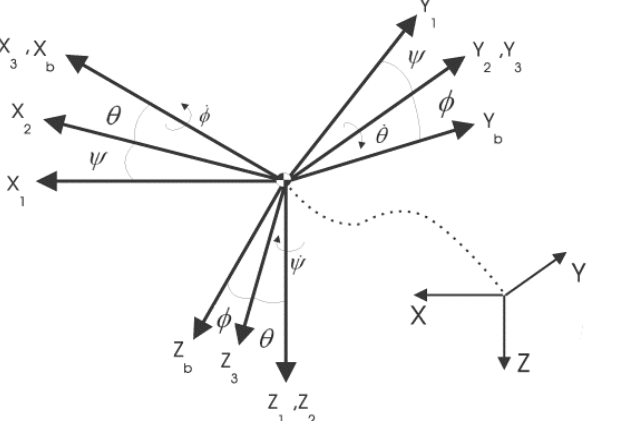
Fig. 1. The body-fixed, vehicle carried and the earth-fixed axes